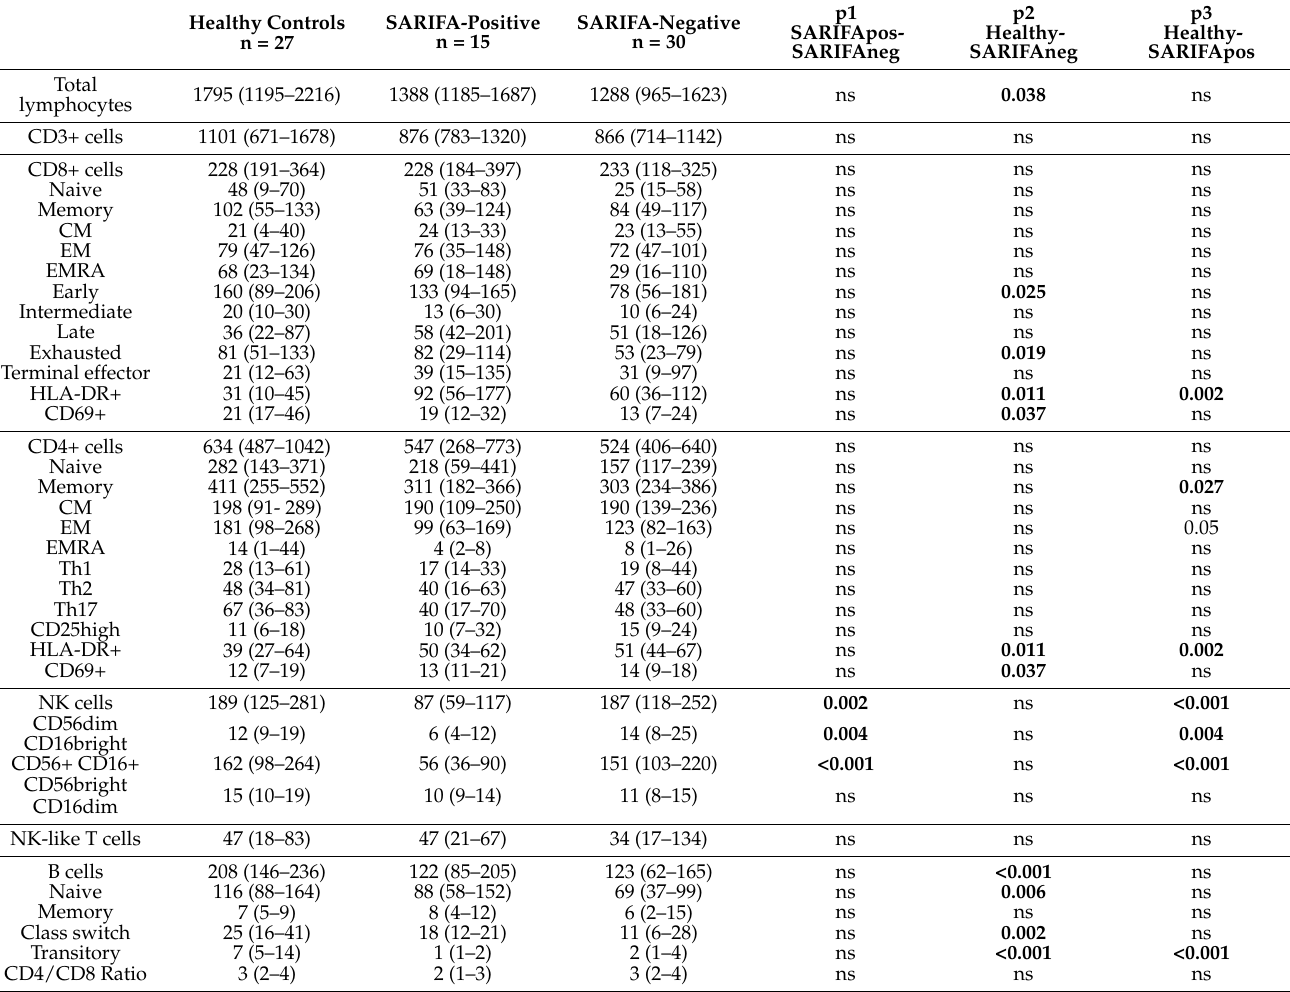
Table 3. Lymphocyte subsets in healthy controls, SARIFA-positive and SARIFA-negative CRC